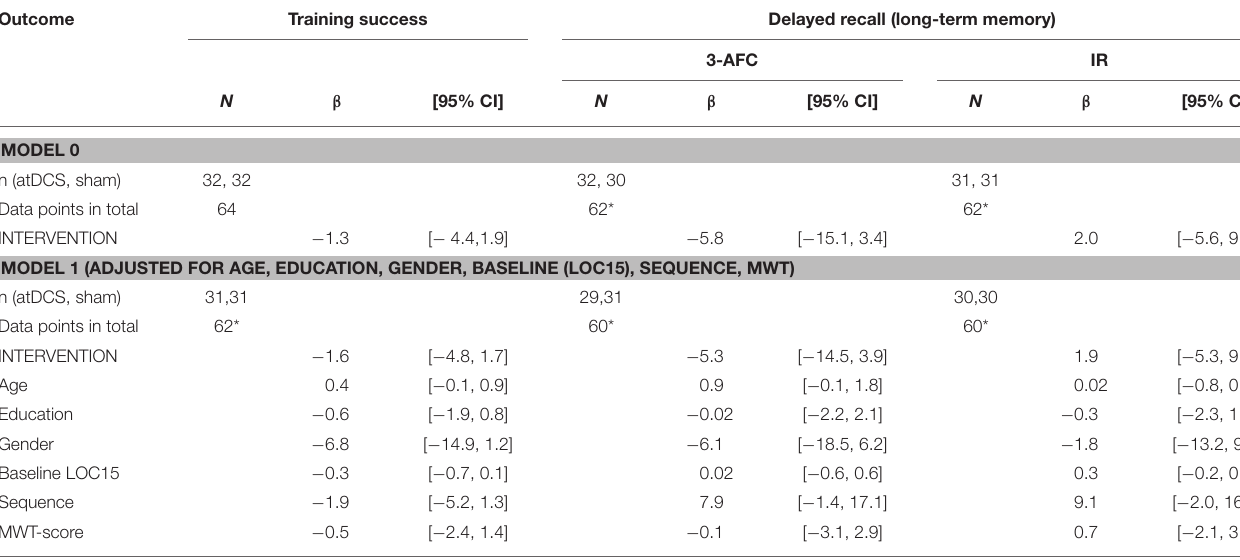
TABLE 2 | Results of separate linear mixed models analysis with factor “INTERVENTION” (atDCS vs. sham) for training success and delayed recall after 1-month (measured by 3-AFC and IR) without (MODEL 0) and with adjustment (MODEL 1). Outcome Training success Delayed recall (long-term memory)